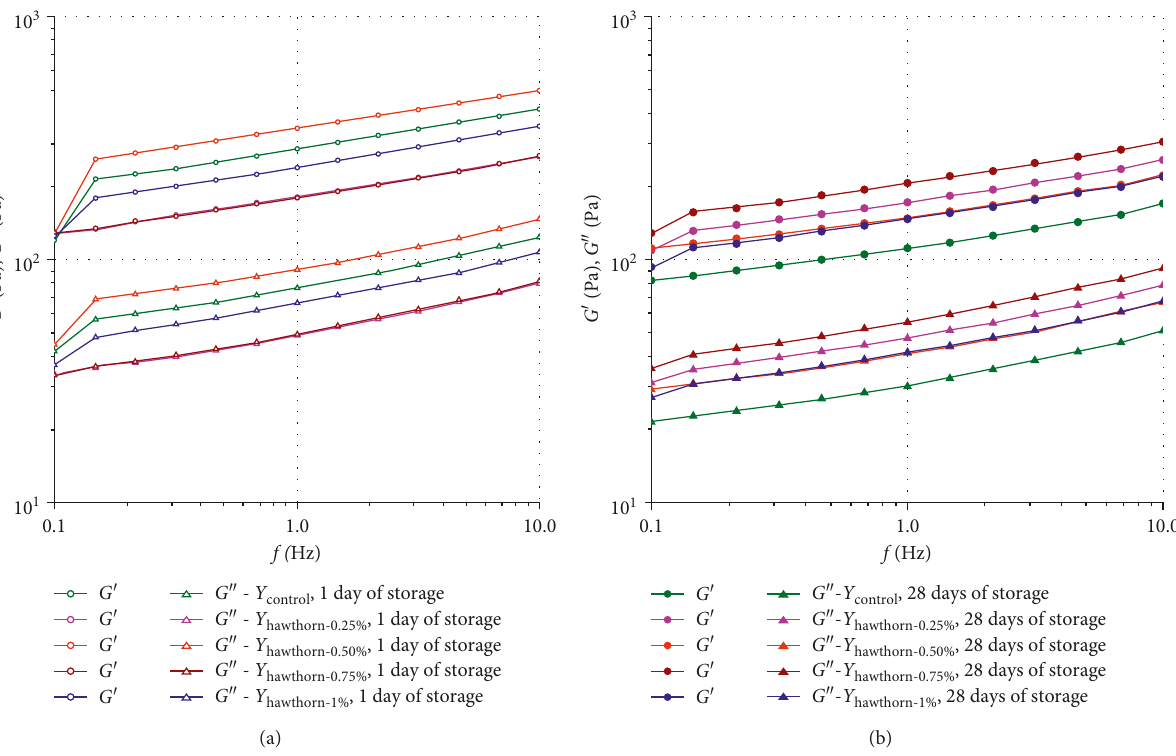
Figure 6: Viscoelastic properties of yogurt with hawthorn ( Crataegus monogyna ) extract: (a) 1 day of storage; (b) after 28 days of storage.